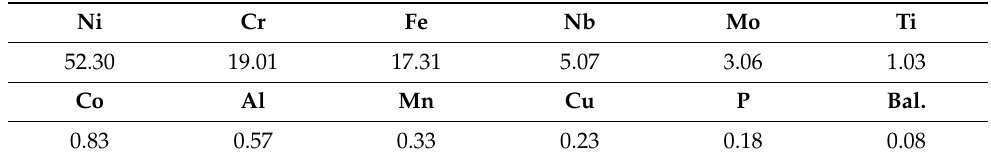
Table 2. Relevant test parameters of residual stress tester.